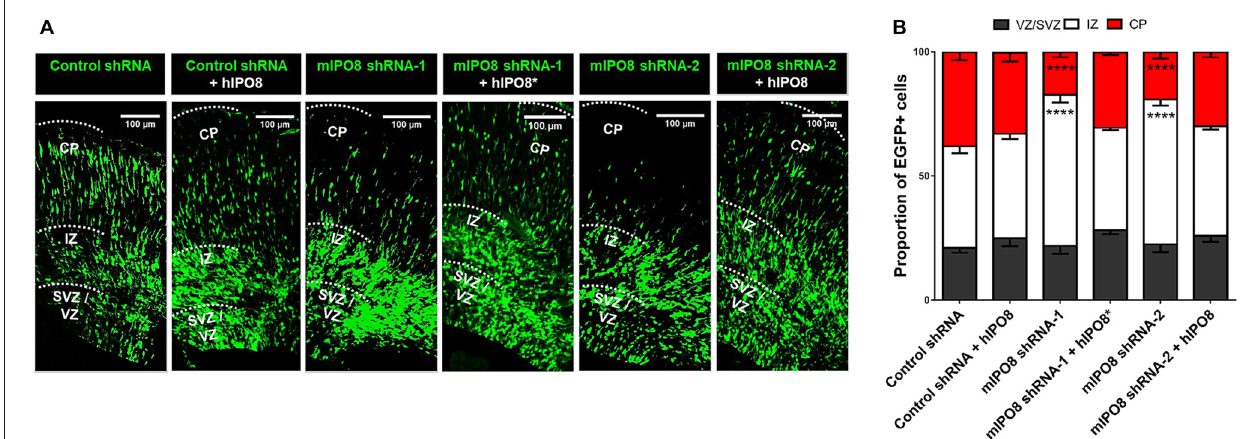
FIGURE 2 | Acute Ipo8 knockdown alters radial migration of projection neurons in the cerebral cortex. (A) Distribution of EGFP-positive cells 3 days after in utero electroporation (IUE) at E14.5. For knockdown experiments, only the plasmid co-expressing EGFP and either a control shRNA or an shRNA directed against mIPO8 (shRNA-1 and shRNA-2) was electroporated. For rescue experiments, a plasmid overexpressing a HA-tagged hIPO8 ∗ CDS along with the one producing mIPO8 shRNA-1, or one expressing HA-tagged hIPO8 CDS along with another producing mIPO8 shRNA-2 or control shRNA, were co-electroporated. (B) Proportion of EGFP cells in the different cortical regions. The control shRNA condition was taken as reference for statistical analysis. ∗∗∗∗ p < 0.0001. VZ/SVZ, ventricular/subventricular zone; IZ, intermediate zone; CP, cortical plate. Scale bar: 100 µ m.